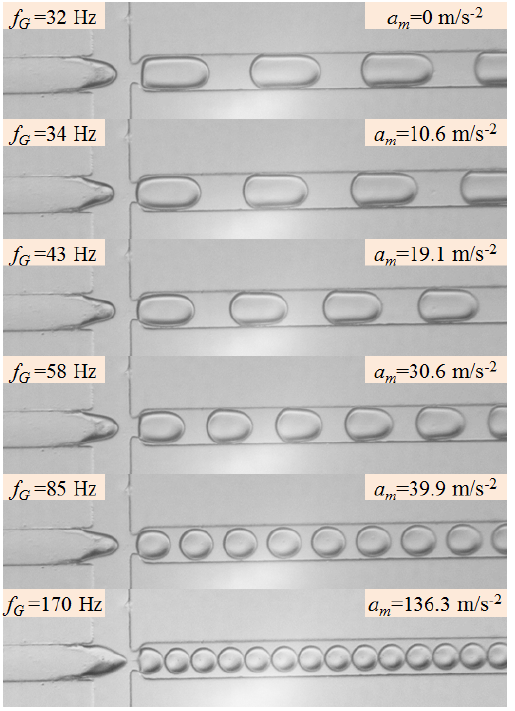
Figure 6. Droplet generation snapshots at di ff erent vibration amplitudes. ( Q c = 60 µ L / h, Q d = 60 µ L / h, f P = 170 Hz; f G are marked on the upper left corner; a m are marked on the upper right corner.).